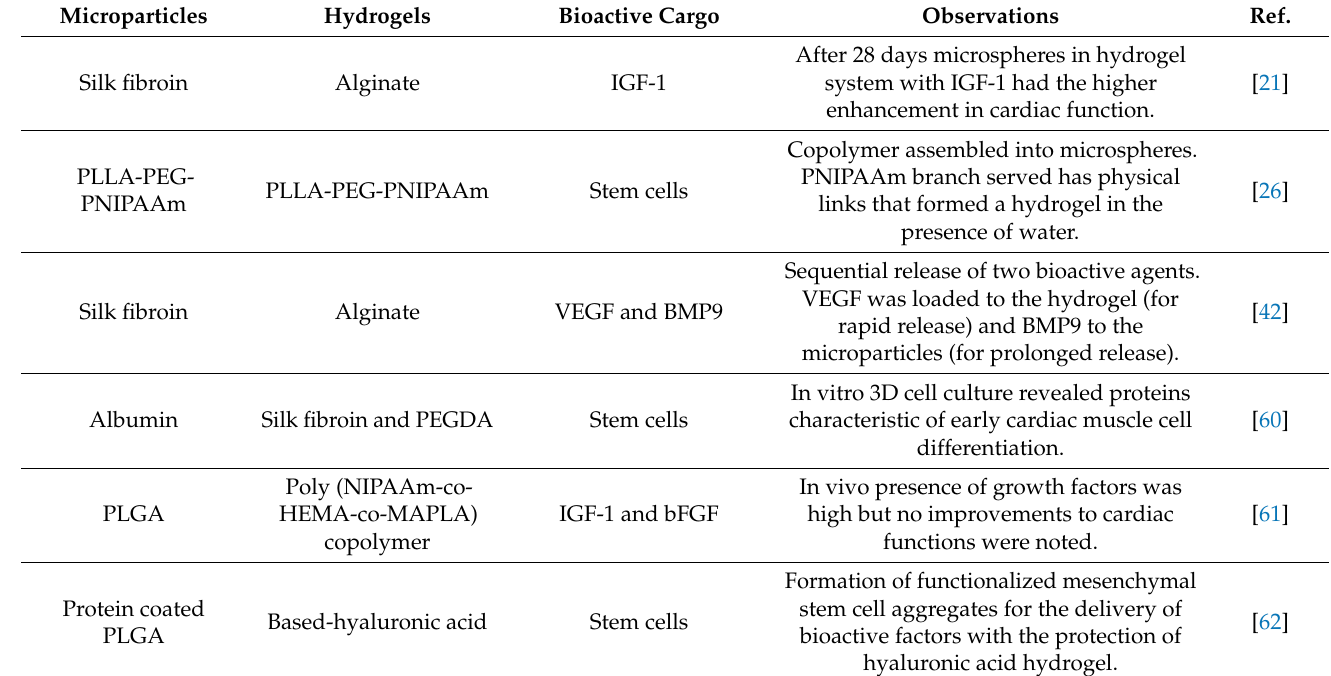
Table 2. Microparticles in hydrogel systems for cardiovascular diseases